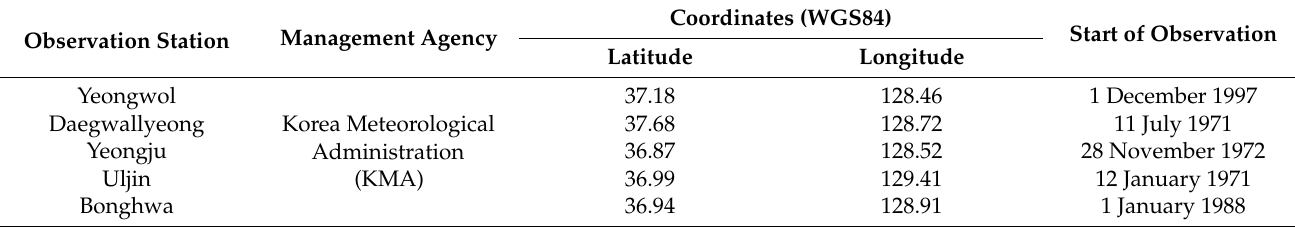
Table 3. Specifications of rainfall station (reprinted from [8]).